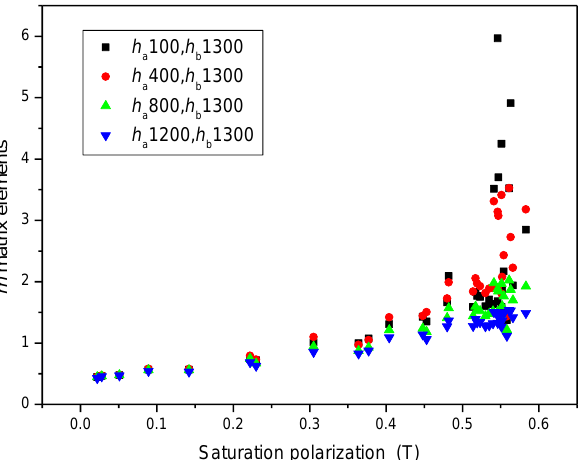
Figure 12. m matrix elements taken from four areas of permeability as functions of the saturation polarization. In this figure, all measured points are taken into account. Figure 13 is a magnification of the part of Figure 12 where only ( h a = 1200 and h b = 1300) MAT descriptors are taken into account, but the different sample series are marked by different colours. The parameter in this figure is the temperature of the heat treatment. The equivalence of ( h a = 1200 and h b = 1300) MAT parameters and the saturation induction is evident, regardless of the individual samples.